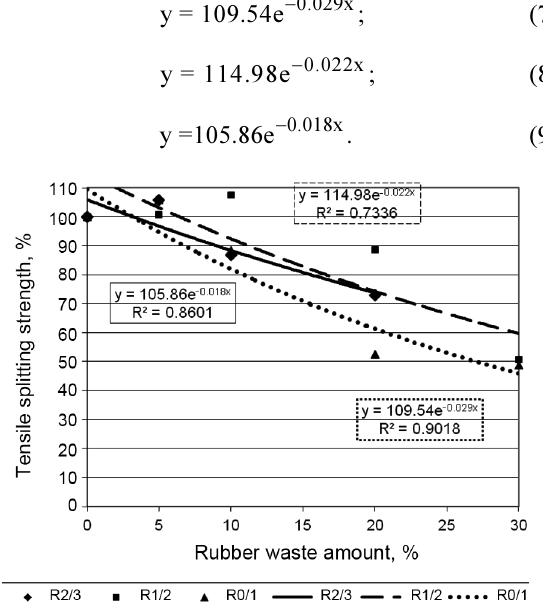
Fig. 10. Effect of CR amount and size fraction on the splitting tensile strength of